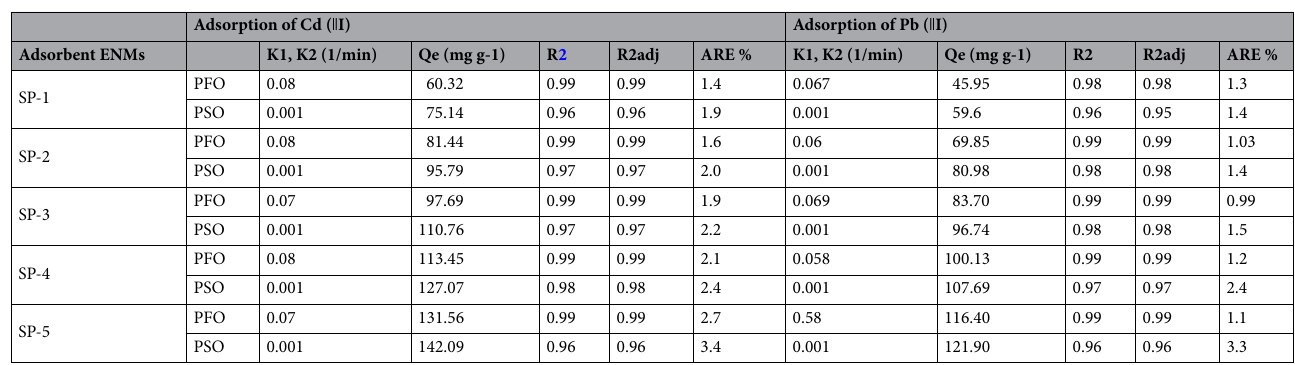
Table 4. Adsorption kinetic parameters for Cd(II), and Pb(II) uptake onto SP-1, and SP-2, 3, 4, 5 ENMs for non-linear PFO and